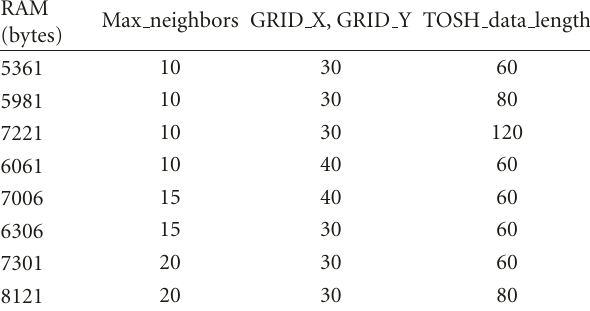
Table 2: Node resources required for the implementation of the localization